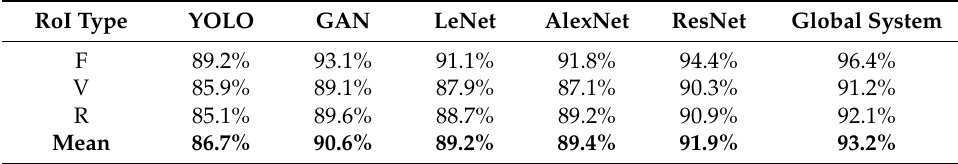
Table 6. Accuracy comparison with primary